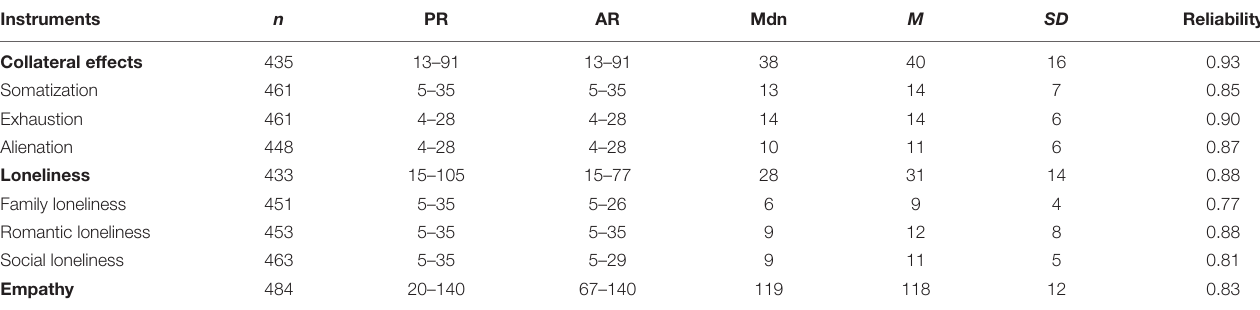
TABLE 1 | Descriptive statistics and psychometric reliability of scales of collateral effects, loneliness, and empathy in a sample of Spanish healthcare professionals.